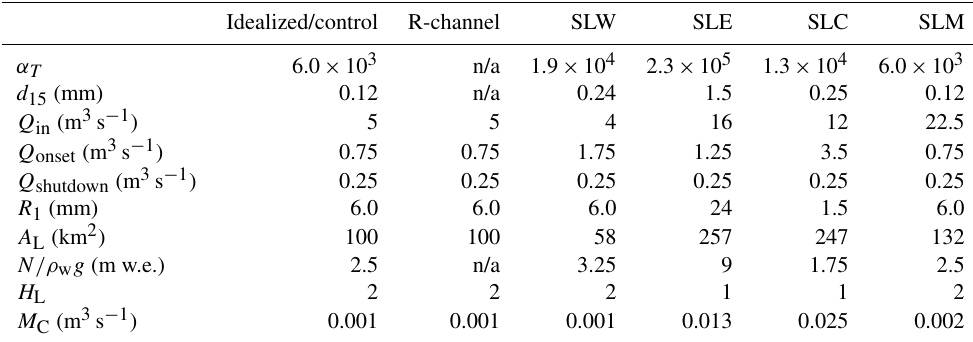
Table 2. List of parameters used for each of the experiments. “n/a” stands for not applicable. Idealized/control